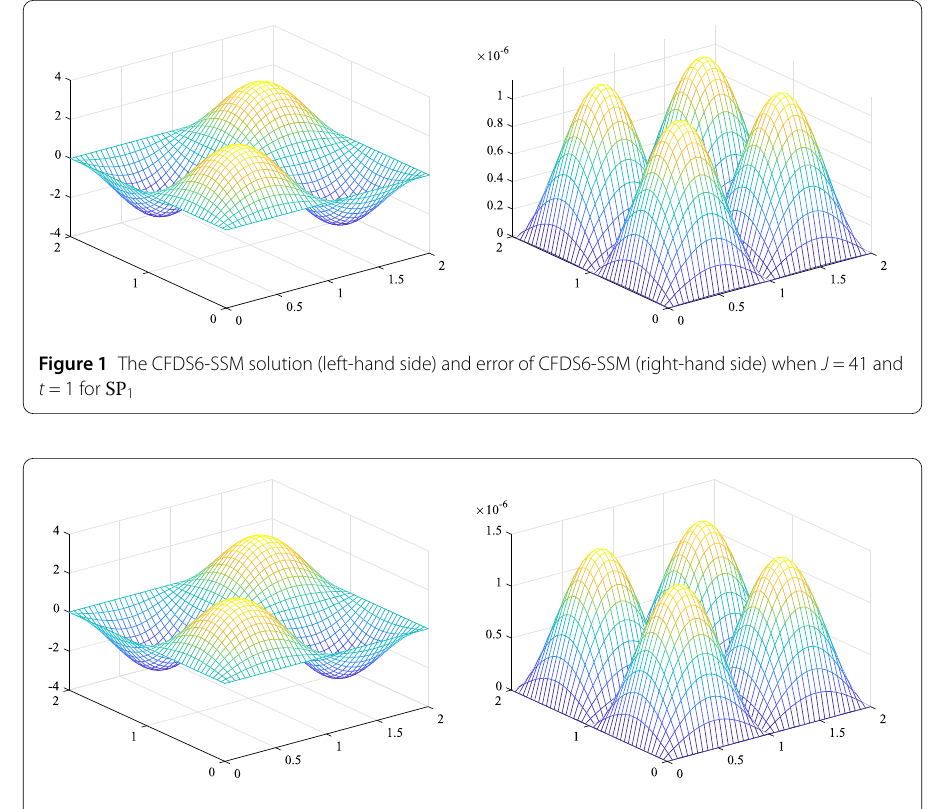
Figure 2 The E-CFDS6-SSM solution (left-hand side) and error of E-CFDS6-SSM (right-hand side) when J = 41 and t = 1 for SP